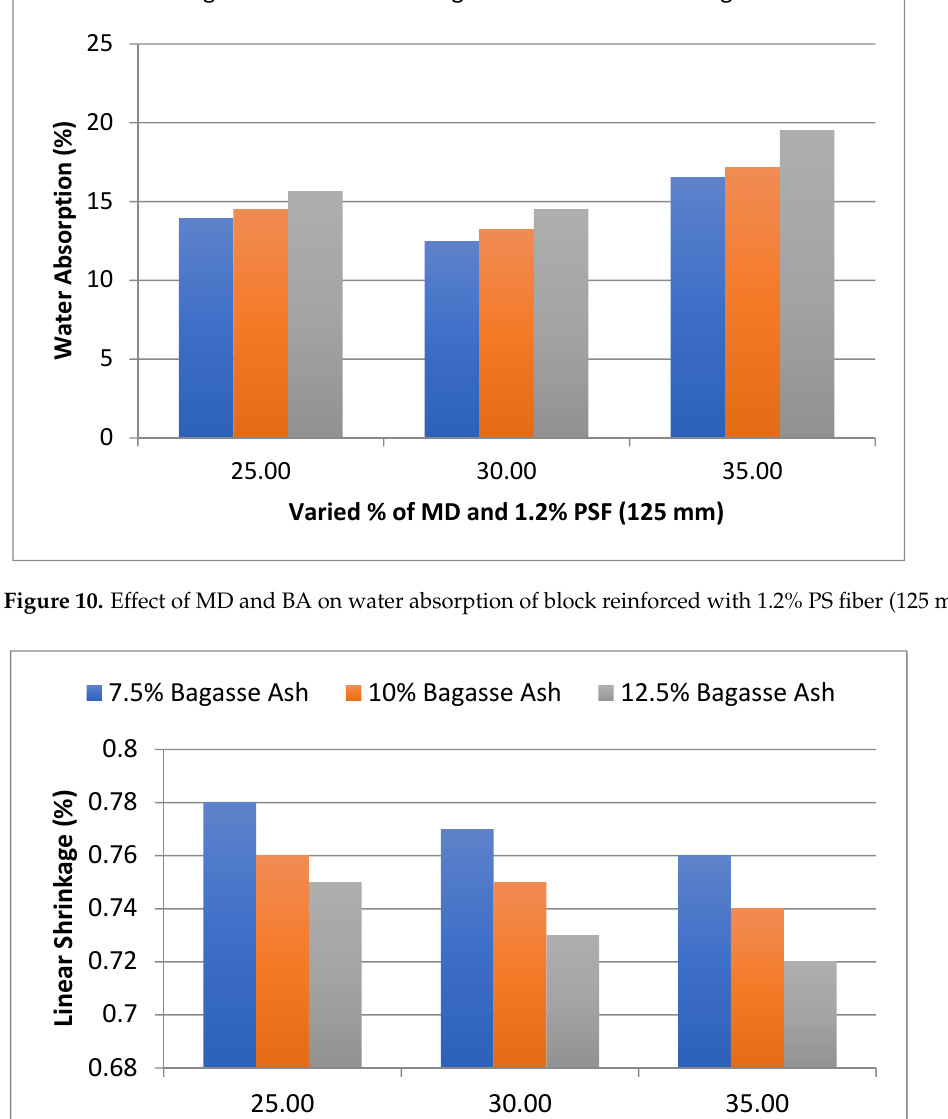
Figure 10. Effect of MD and BA on water absorption of block reinforced with 1.2% PS fiber (125 mm).